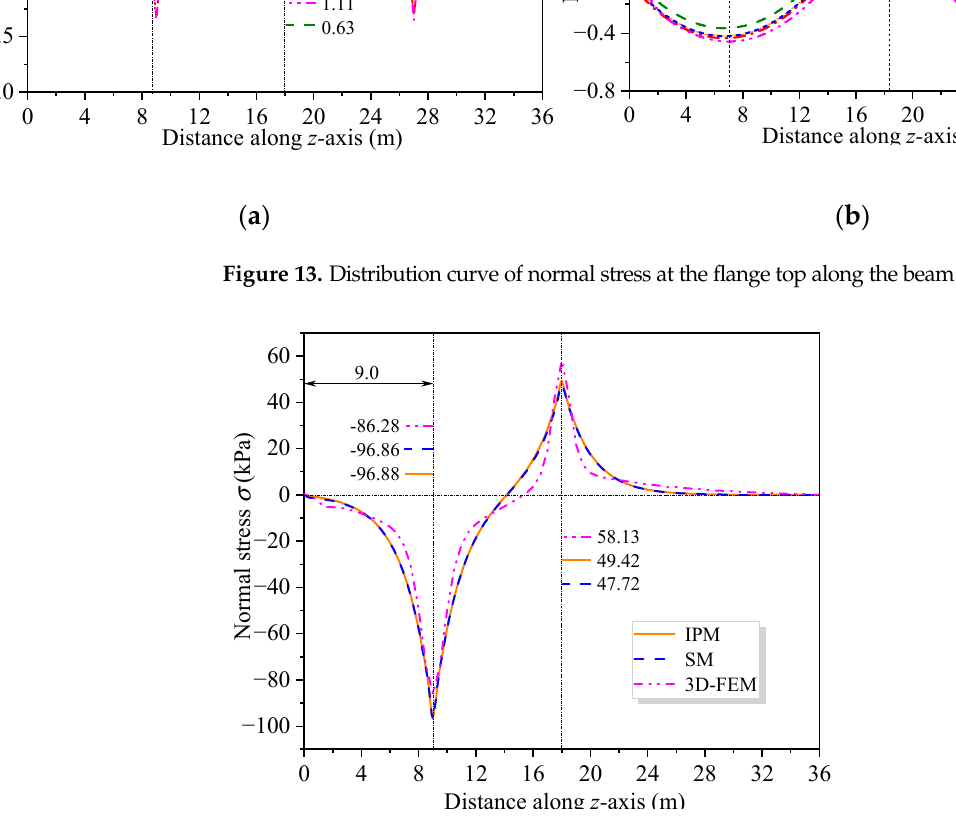
Figure 14. Distribution curve of flange torsional warping normal stress along the beam axis.